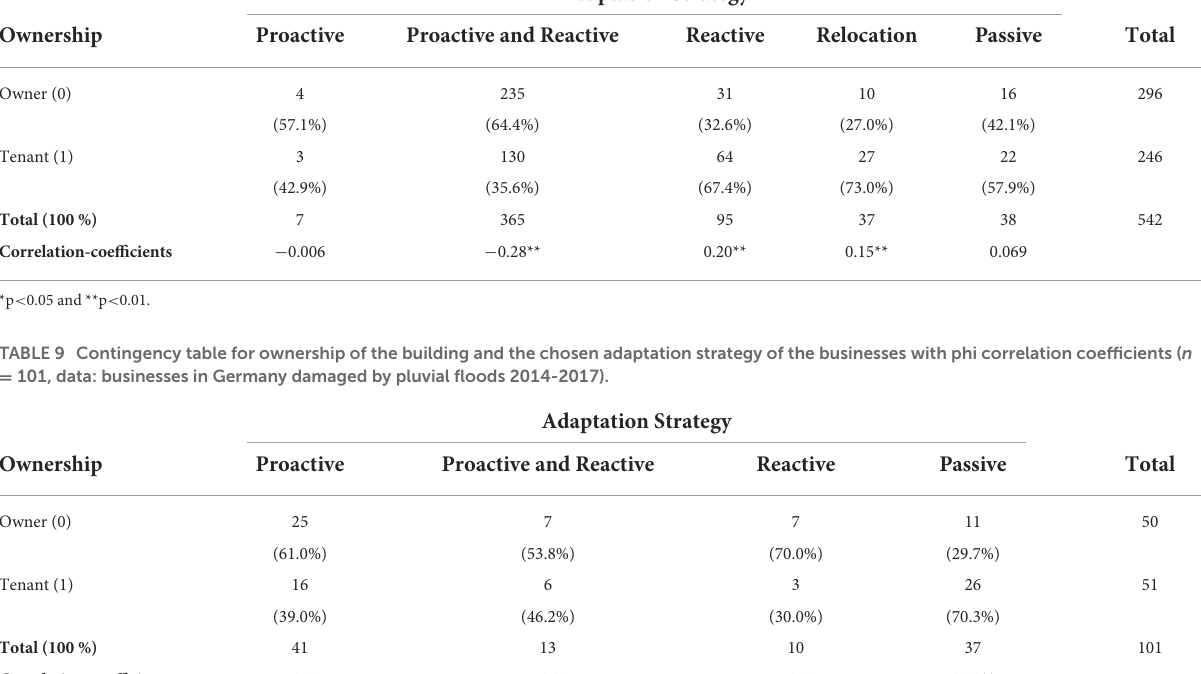
TABLE 8 Contingency table for ownership of the building and the chosen adaptation strategy of the businesses with phi correlation coefficients ( n = 542, data: businesses in Germany damaged by the 2013 flood). Adaptation Strategy